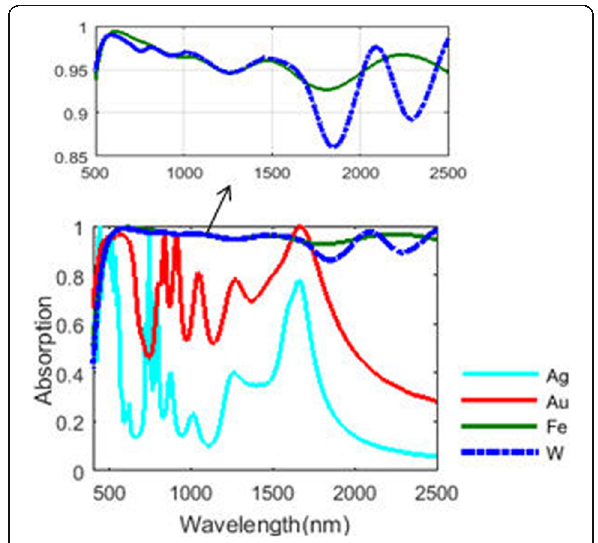
Fig. 12 Absorbing spectra varying with layer thickness hh in the eight-layer Fe-NPA